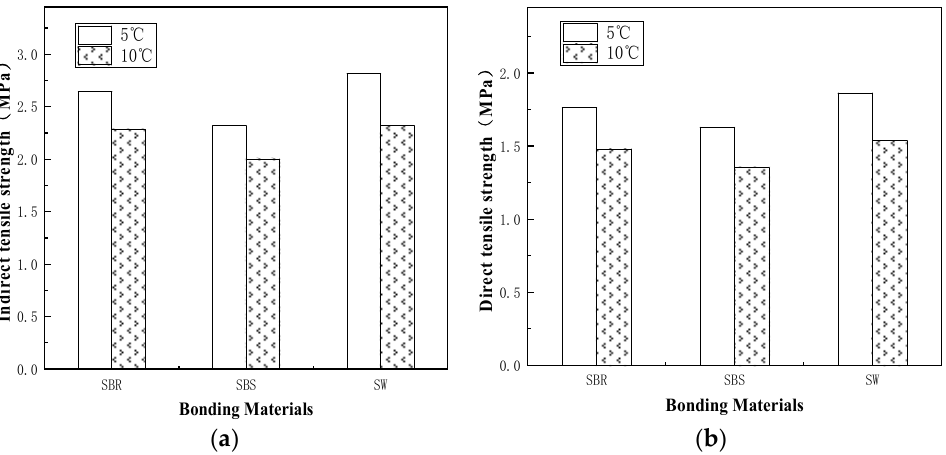
Figure 11. Comparison of tensile strength of bonding materials: ( a ) indirect tensile test; ( b ) direct tensile test.